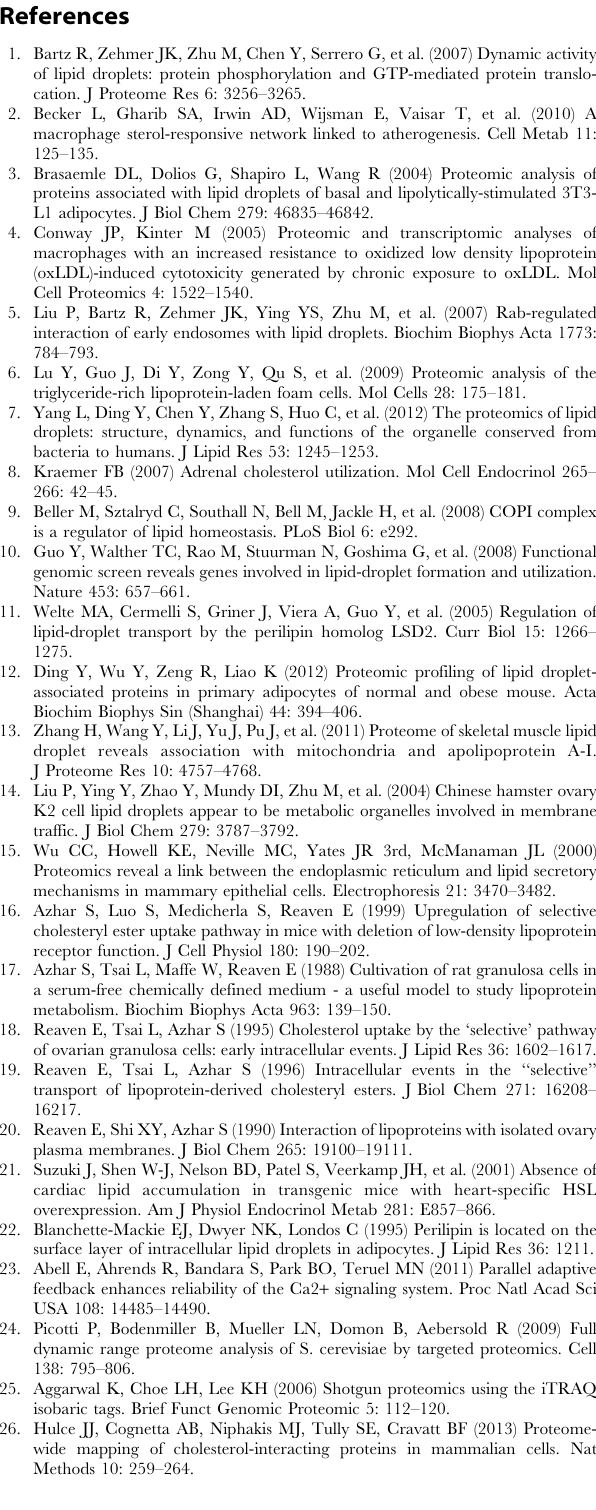
Table S1 List of peptides and transitions used for selected reaction monitoring mass